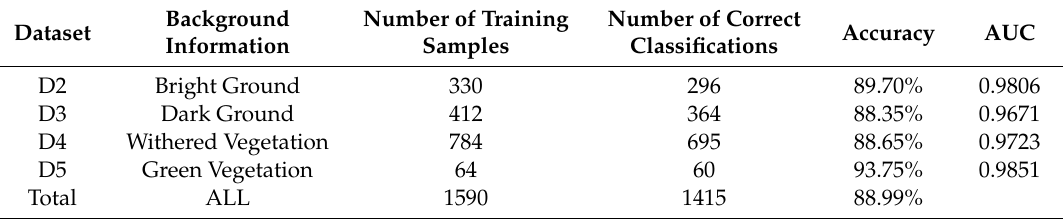
Table 12. Final classification result by the method proposed in this